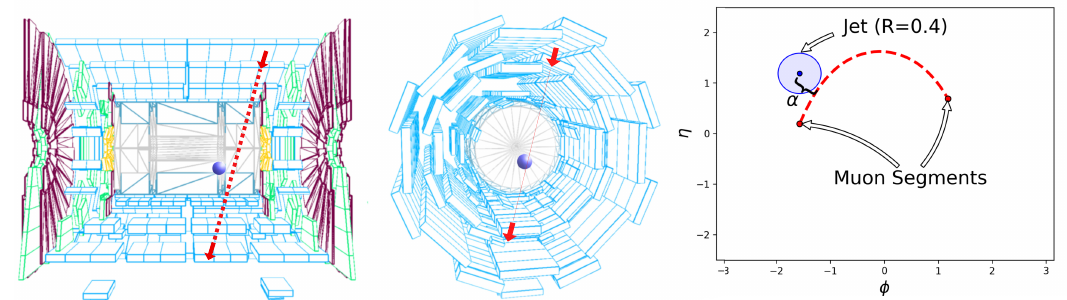
Figure 3 . Example illustration of the construction of the α variable. Left: longitudinal view demonstrating the assumed cosmic-ray muon trajectory for a given pair of muon segments and a leading jet. The location of the calorimeter energy deposition forming this jet is shown as a blue sphere. Middle: transverse view demonstrating the assumed cosmic-ray muon trajectory for a given pair of muon segments and a leading jet. Right: an η – φ plane view of the assumed cosmic-ray muon trajectory between a pair of muon segments, and the ∆ R that corresponds to the α variable in this example. In this case the α value is greater than the size of the jet radius parameter ( R = 0 . 4